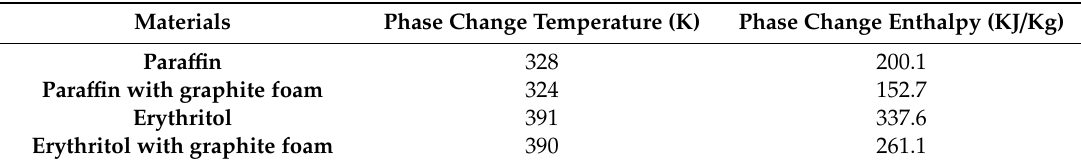
Table 1. Properties of composite phase change